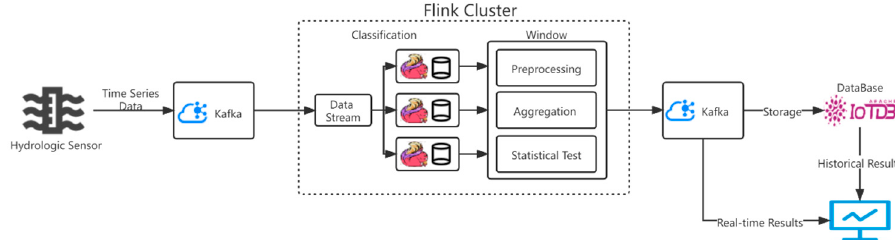
Figure 2. System